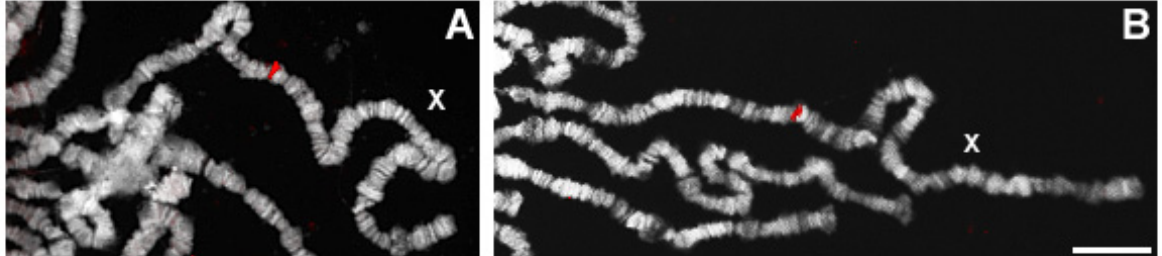
Figure 5. ( A , B ) Localization of crysi3 and crymau3 Cy3-labeled probes, on the polytene chromosomes of D. simulans ( A ) and D. mauritiana ( B ) stained with DAPI. Scale bar indicates 10 µm. Cytological mapping of crysi3 and cryse3 on the polytene X chromosome of D. simulans and D. sechellia was in accordance with sequence alignment data with the respective sequenced genome and showed the presence of the cloned sequence in contigs belonging to the X chromosome (GB: CM2002914; GB: